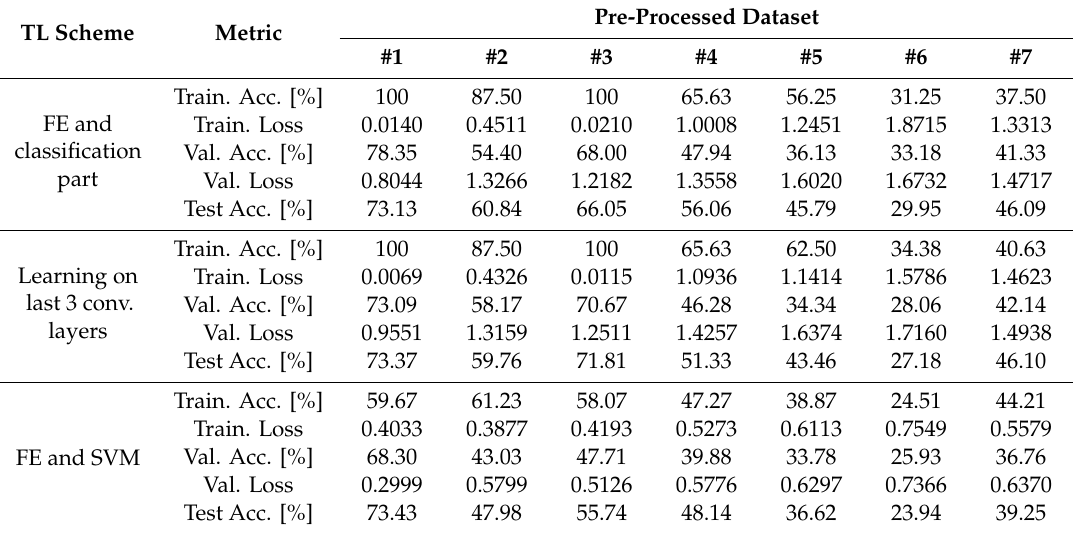
Table 5. Training, validation and test accuracy, and loss for di ff erent transfer learning schemes on the AlexNet-based network (DRGV pre-processed